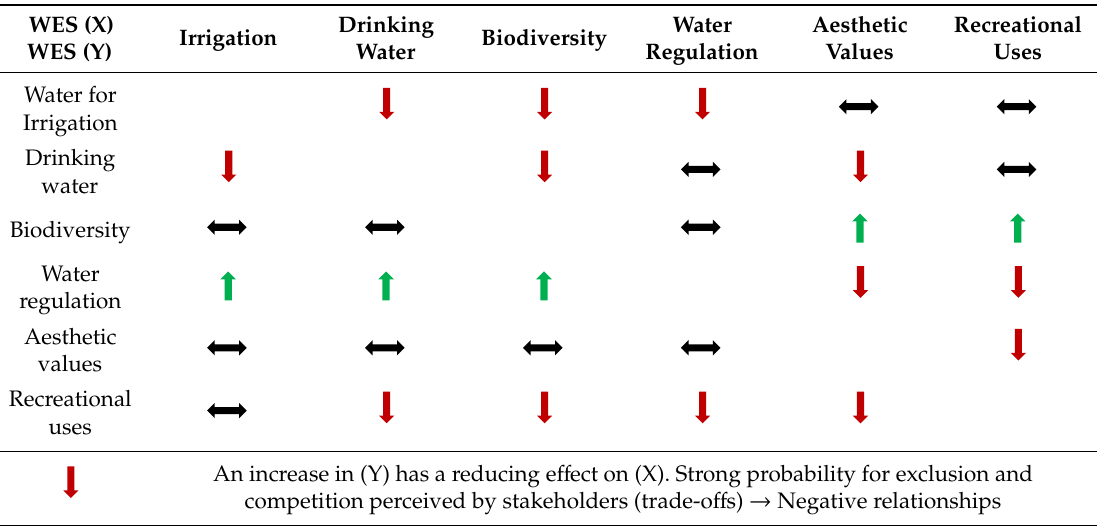
Table 5. Direct interactions between water ecosystem services (WES) in the Muga river basin as perceived by